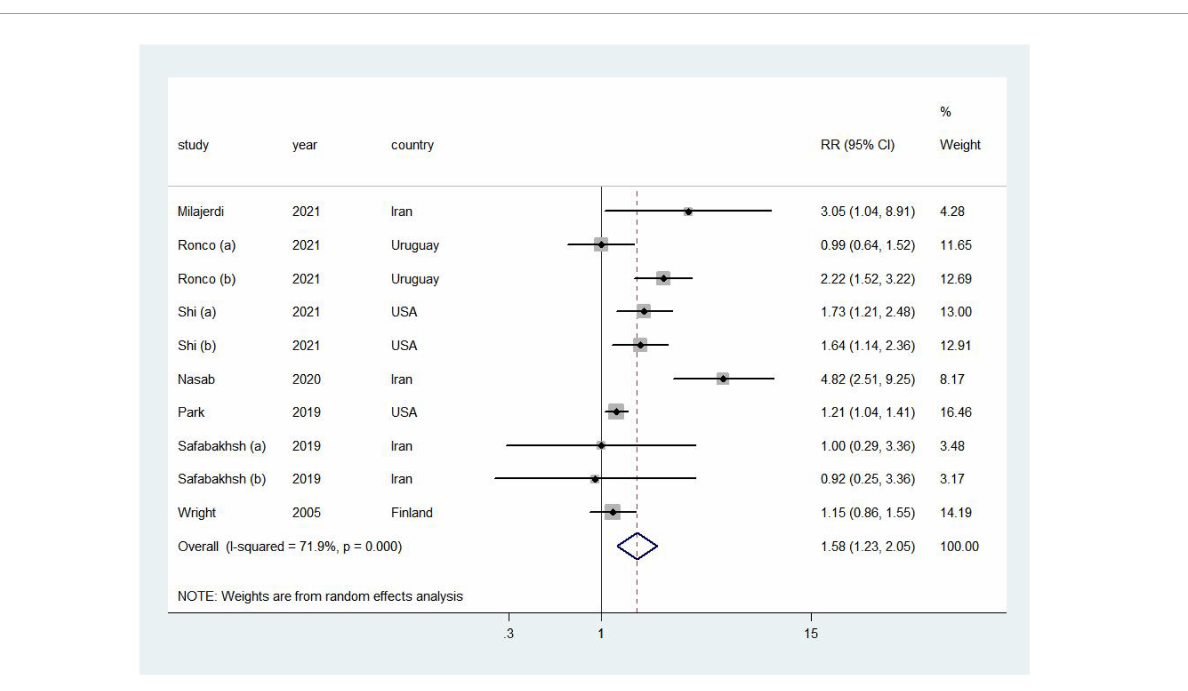
FIGURE2 Forest plot (a random-effects model) of the association between DAL and cancer risk (highest vs. lowest). Squares indicate study-specific relative risk (RR), where the size of the square reflects the study-specific statistical weight; horizontal lines indicate the 95% CI; and diamonds denote the summary RR with 95%